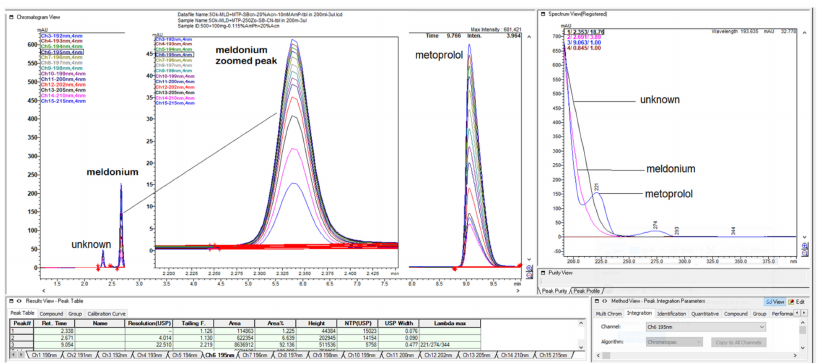
Figure 27. Chromatograms with column Zorbax CN-SB-250 × 4.6 mm with 20% ACN and 80% 13 mM (0.15% w / v ) NH 4 H 2 PO 4 and overlaid 15-channels of different UV-absorbing wavelengths, with an expanded, zoomed peak of meldonium for better visibility in comparison with metoprolol.